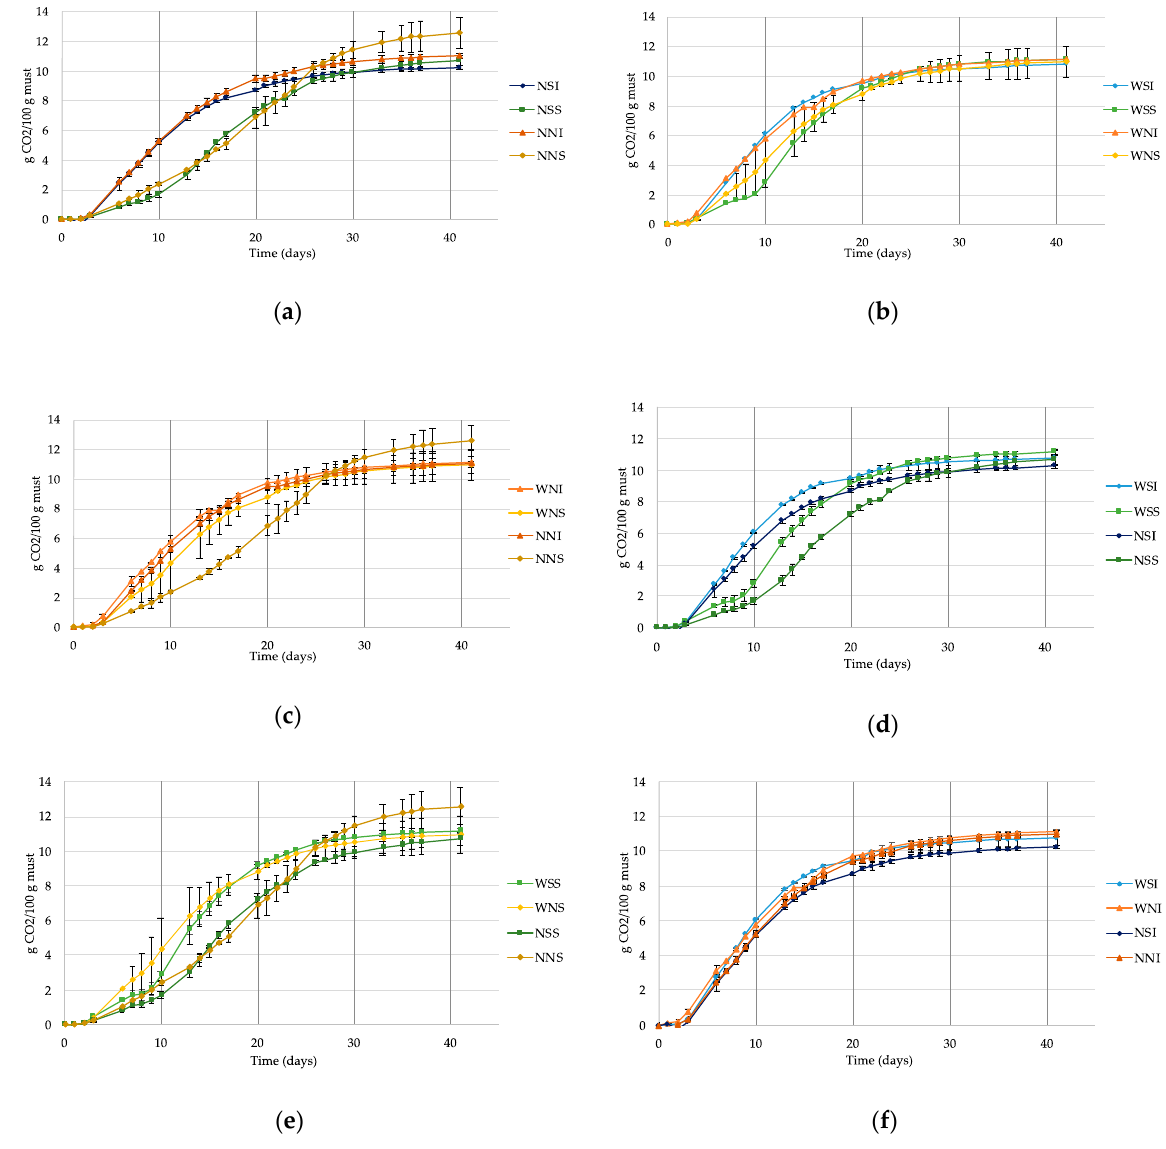
Figure 3. Fermentation kinetics of the eight types of microvinification trials of grape musts grouped according to treatment: washing (top panels, first letter N or W), SO 2 addition (middle panels, second letter N or S), and starter inoculation (bottom panels, third letter S or I). Non-washed ( a ) or washed grapes ( b ), no addition ( c ) or addition of SO 2 ( d ), spontaneous ( e ) or inoculated fermentation ( f ).